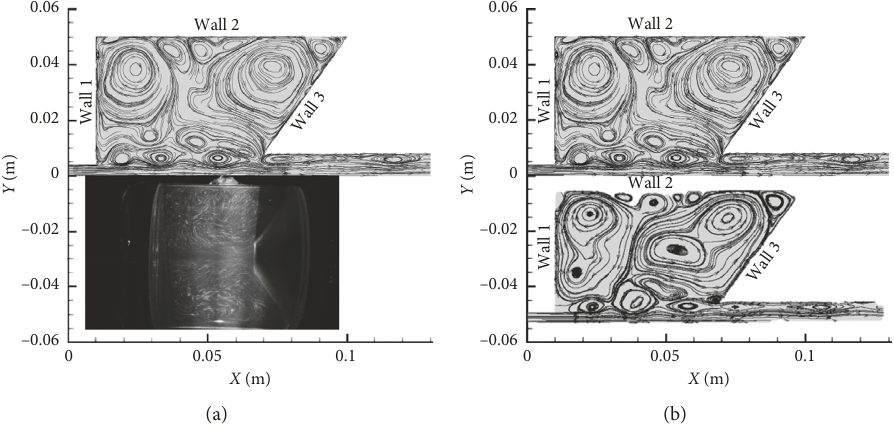
Figure 8: Instantaneous vorticity partitioning in cavitation jet nozzle. (a) Comparison diagram for numerical simulation and experiment. (b) Distribution of instantaneous vortex structure.